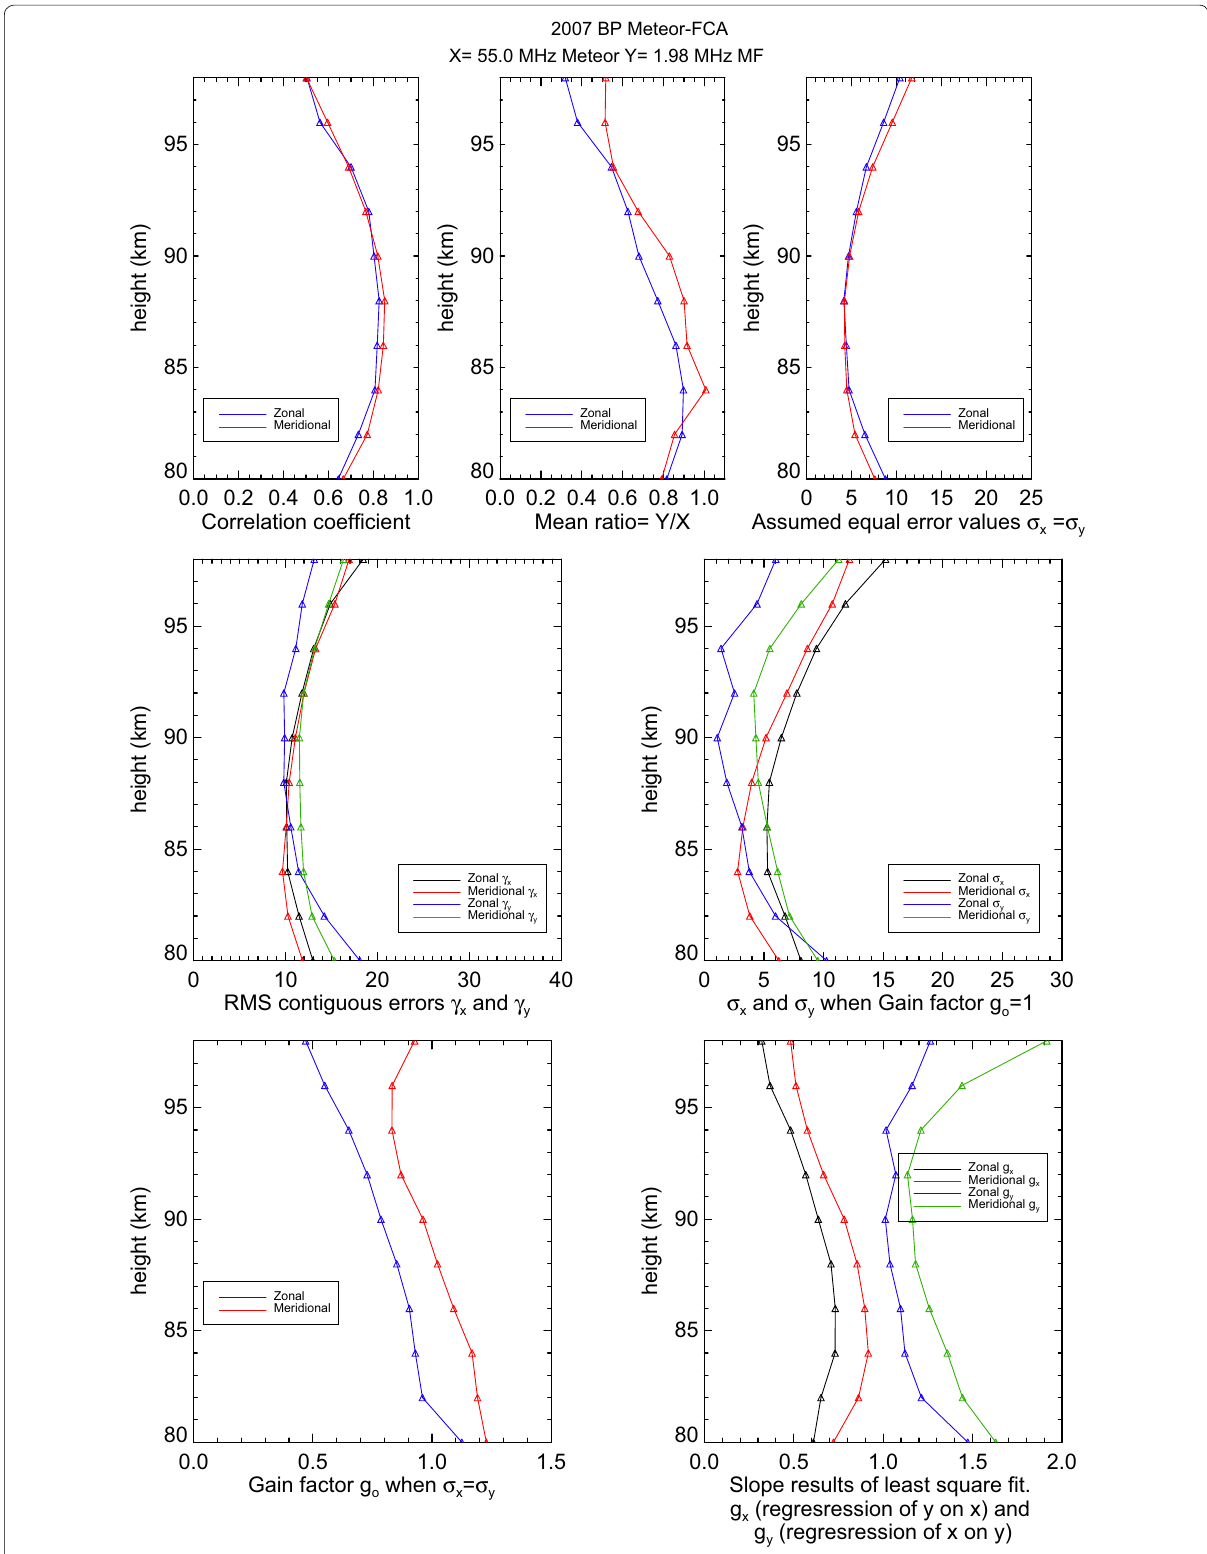
Fig. 8 BP 55 MHz meteor and MF PR FCA wind comparison for 2007. The plots above summarize the results from applying the regression analysis to the data at all heights. In the fourth, fifth, and last panels, red and black indicate the 55 MHz radar and green and blue the 1.98 MHz radar